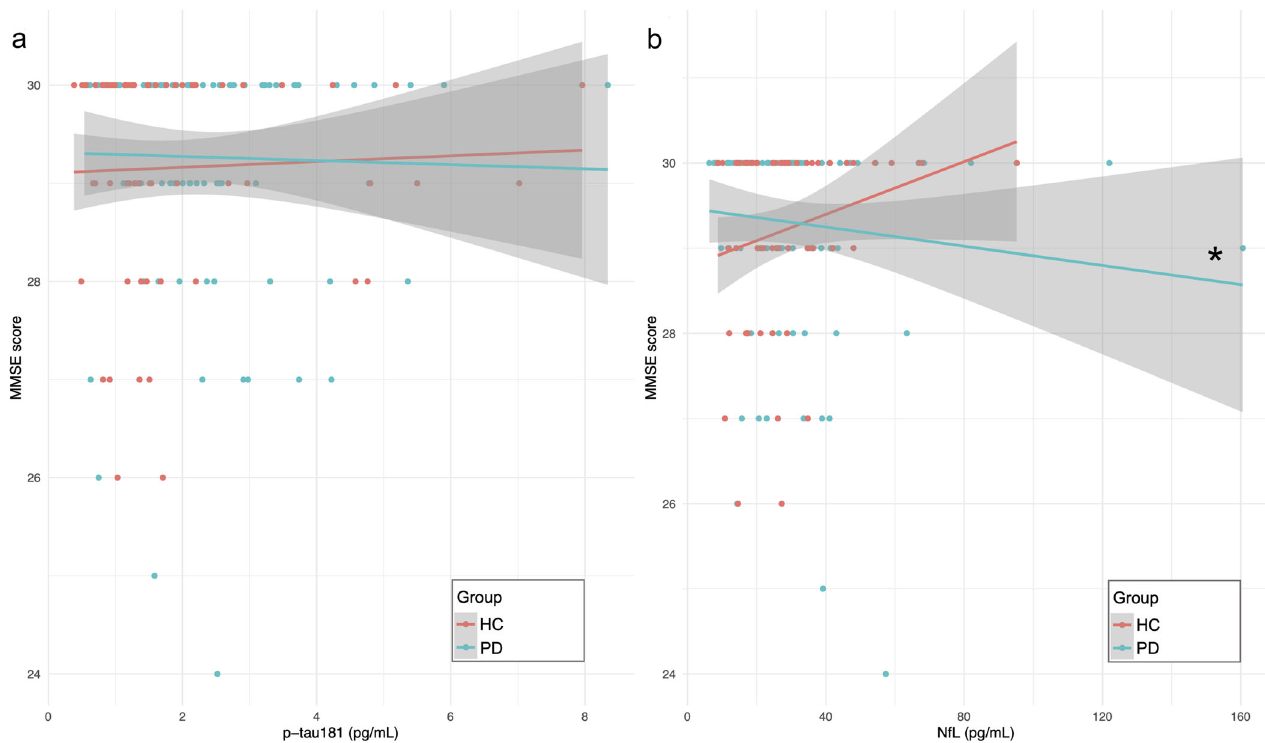
Fig. 2 Association of baseline MMSE scores with plasma p-tau181 and NfL concentrations. Graphs representing MMSE score data points and regression lines in the PD group (blue line) and HC group (pink line) as function of plasma p-tau181 concentrations ( a ) and plasma NfL concentrations ( b ). *Signi fi cant linear regression model, with MMSE scores as dependent variables and plasma NfL as predictor, while adjusting for age, sex and years of education (Standardised β = 0.240, P = 0.027, overall regression model: R2 = 0.152, P = 0.002). MMSE Mini- Mental State Examination, PD Parkinson ’ s disease, HC healthy controls, pg/mL picograms per millilitre.